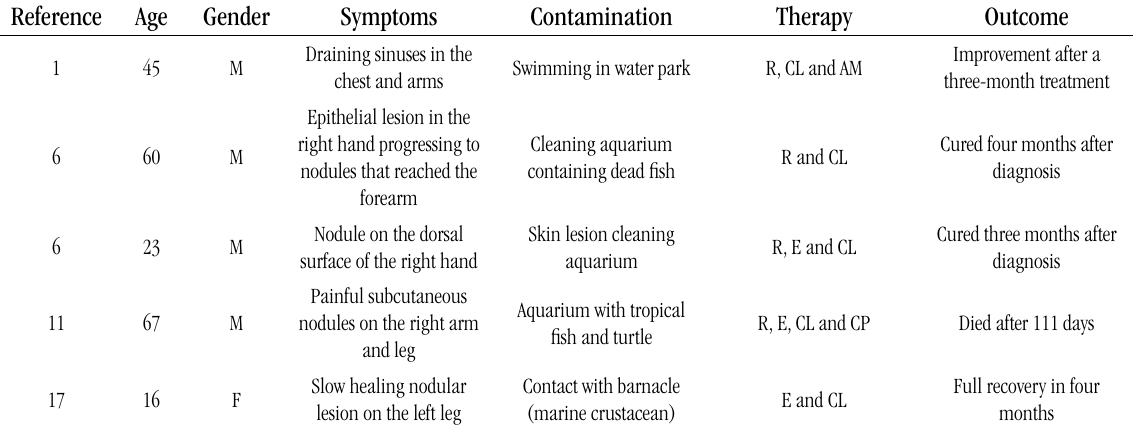
tABLE – Clinical progression of infections caused by M.